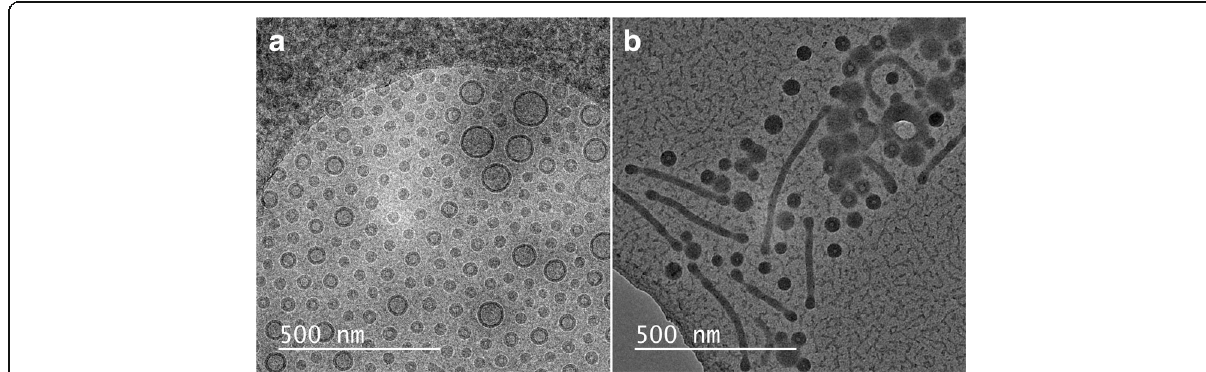
Fig. 1 Micrographs of a sample of polymeric self-assemblies composed of PS-b-PEO 9500-18000 at a concentration of 10 mg/mL. a Micrograph obtained with cryo-TEM. b Micrograph obtained with TEM using